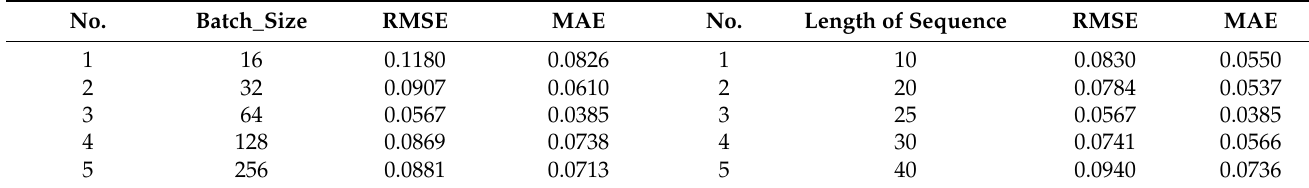
Table 4. Results of the proposed method with different batch size and length of sequences.